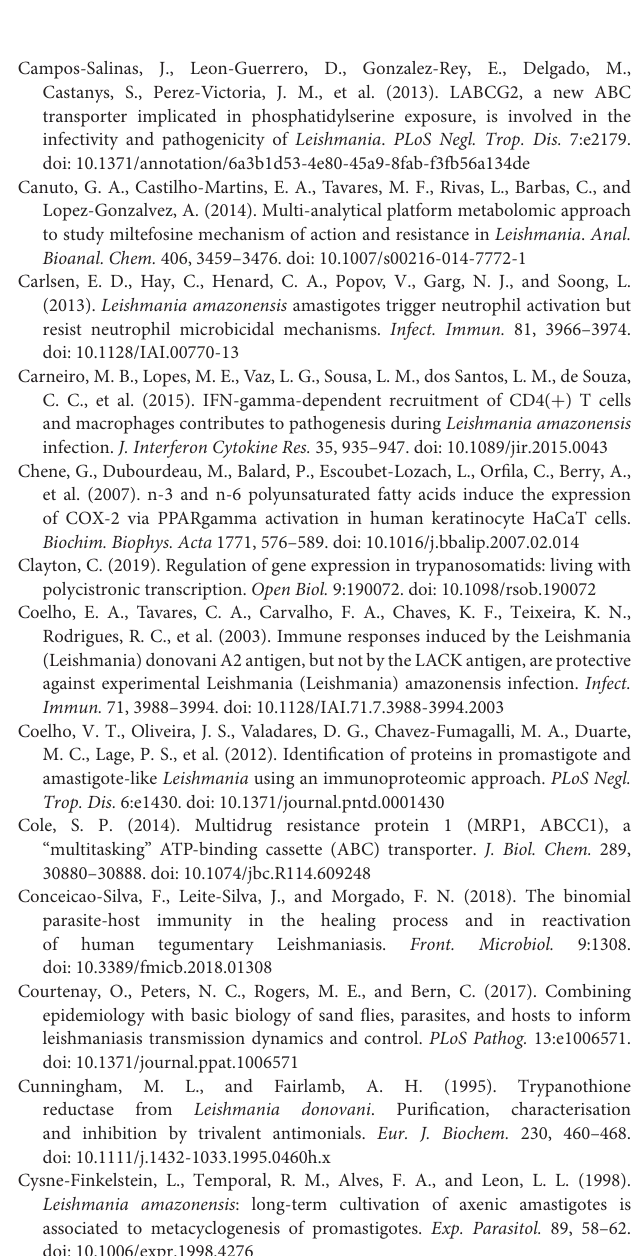
Supplemental Table 1 | Primers for RT-PCR of selected loci. Supplemental Table 2 | List of all metabolites identified by the metabolomic multiplatform fingerprint approach. Confirmed indicates that the compound was putative or truly identified; Feature correspond to a peak or signal that represents a potential metabolite, which should be further identified, according to mass, charge and retention time. M/Z: molecular ion described by its molecular weight in Daltons; RT: retention time for each feature; AVG represent the average of the relative ion abundance present in each investigated group and each metabolite; pV: calculated p -value; Compound ID: compound’s identification number in its respective database; Mass Theor: theoretical molecular mass; MH formula: theoretical formula; Score: probability of matched score from each